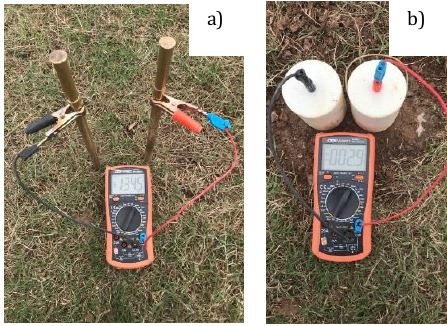
Figure 6: Electrical potential difference when two electrodes are placed at the same location for (a) copper stakes and (b) for Cu/CuSO4 porous